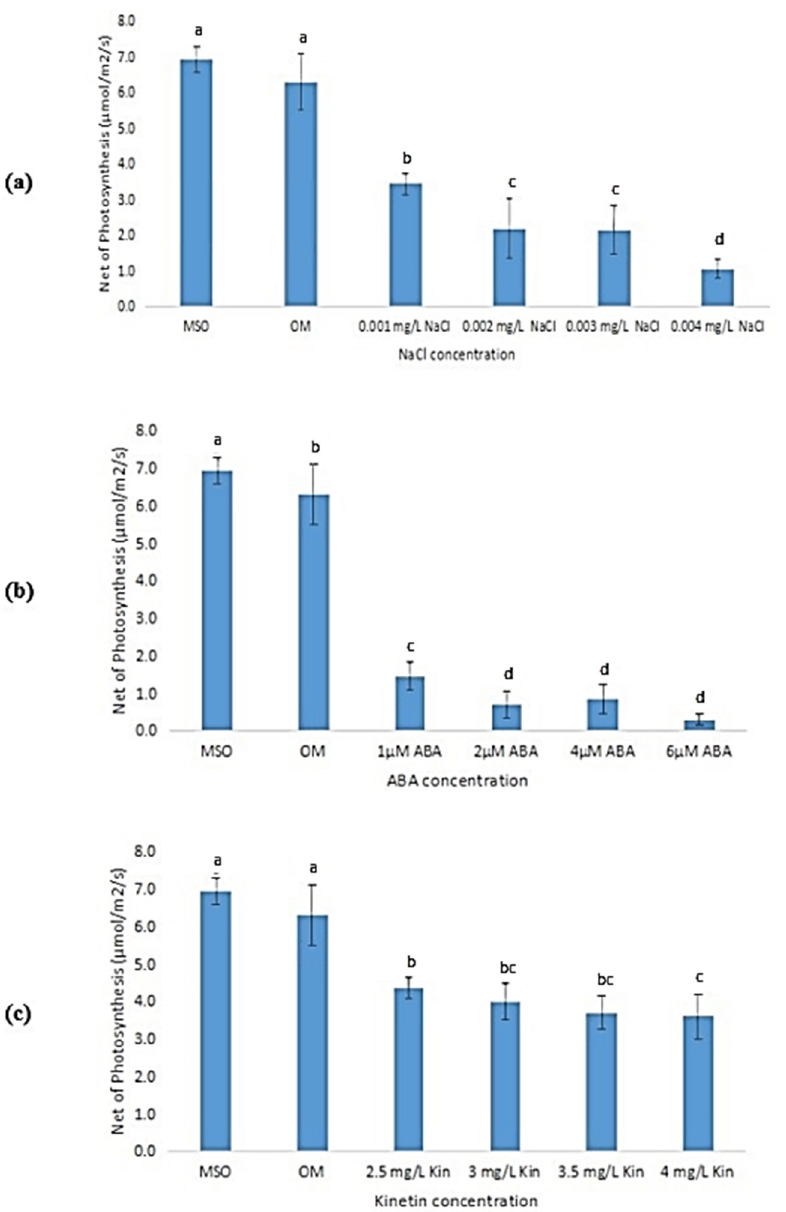
Figure 10. Net photosynthesis of plants exposed to: ( a ) salt stress; ( b ) ABA; ( c ) high kinetin levels. Means with different letters are significantly different at p < 0.05 according to Duncan’s multiple range test (DMRT).